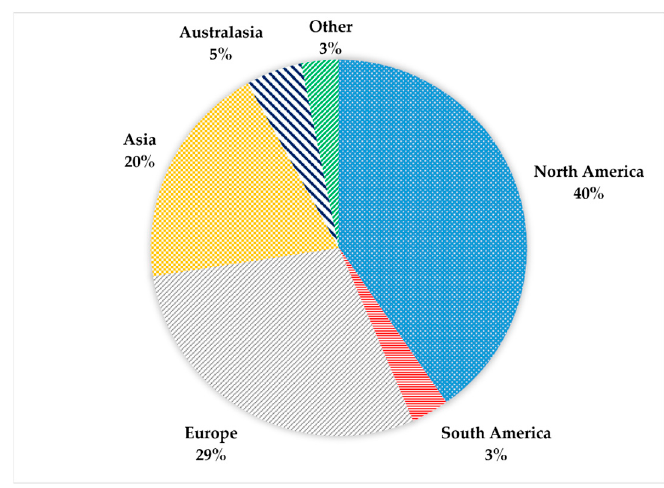
Figure 9. Distribution of studies across the continents.